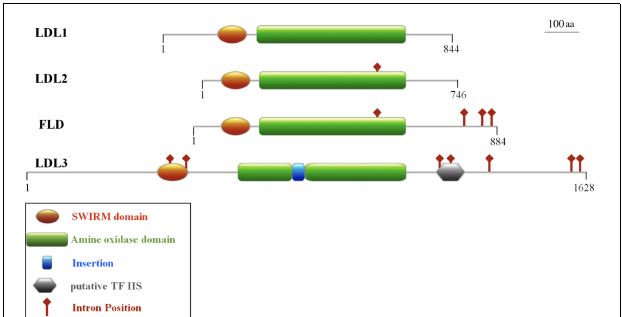
Supplementary Table 2 . Relative expression levels are expressed as fold-changes (2 − (cid:49)(cid:49) Ct ). Reactions were performed in triplicate and mean values ± SE were calculated. At least three independent biological replicates were performed for each experiment, and mean values of relative expression levels from the different biological replicates are